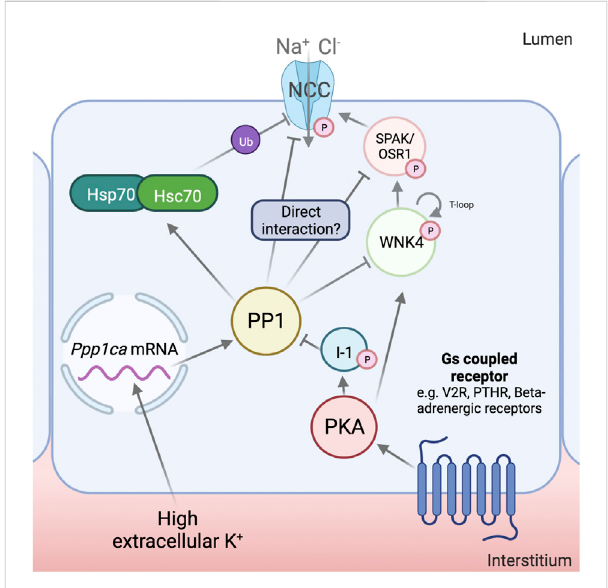
FIGURE 1 Mechanisms for NCC regulation by Protein Phosphatase 1. Protein phosphatase 1 (PP1) has been shownto increaseitsmRNA and proteinabundanceinresponse to high extracellularK + . Inhibitor-1 (I1), in response to cAMP increasing stimuli, is phosphorylated by Protein Kinase A (PKA). This, in turn, results in the inhibition of PP1 activity. PP1 has been shown to regulate With-No-Lysine (K) kinase (WNK4), Ste20-related Proline/Alanine rich Kinase (SPAK) and Na + -Cl - Cotransporter (NCC) phosphorylation, though it is at the moment uncertain if these interactions are physiological and the degree to which theycontribute to NCC regulation.PP1 has also been shown to dephosphorylate and activate the 70 kDa Heat-Shock Protein (Hsp70) and Heat-Shock Cognate 70 (Hsc70), which have been proposed to play an important role in the ubiquitylation and degradation of NCC. Created with